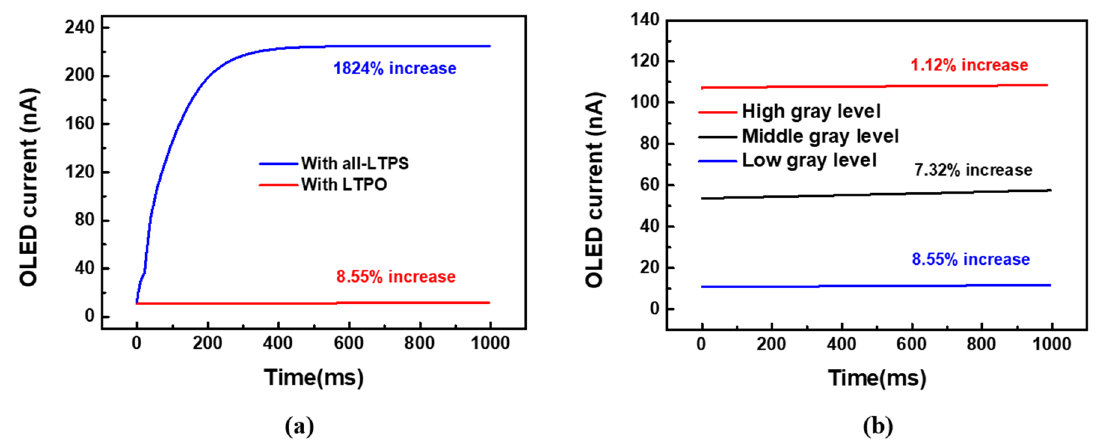
Figure 6. ( a ) OLED current variation with all-LTPS TFT and LTPO pixel circuit for 1 Hz frame rate ( b ) OLED current of high, middle, and low gray levels when the circuit is driven at 1 Hz. Table 1. Comparison of proposed and prior pixel